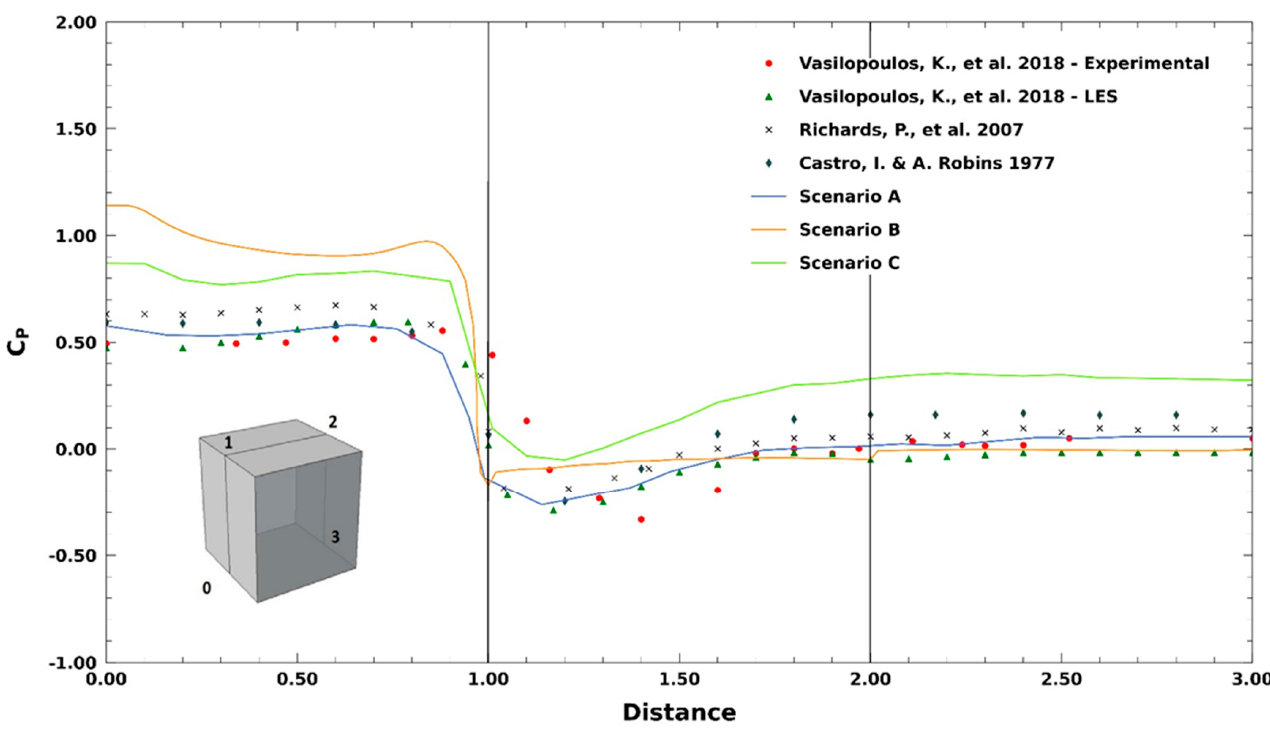
Figure 3. Pressure coefficient distribution at the building’s symmetry plane for Scenarios A − C.